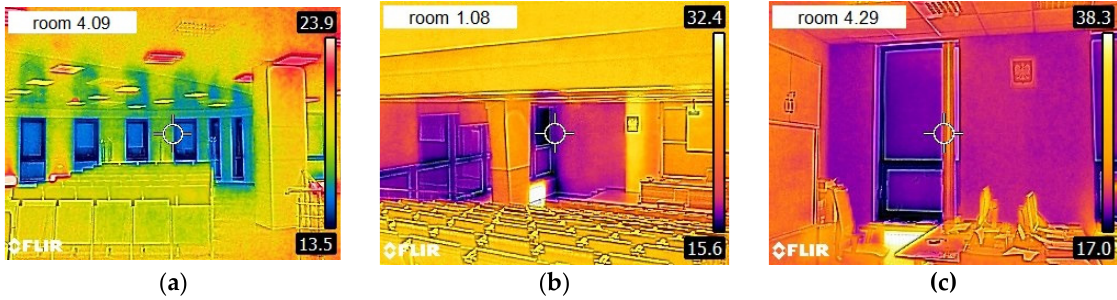
Figure 2. Thermal images from “Energies” ( a ), building “A” ( b ) and Courthouse ( c ). The ventilation ducts (both for air supply and removal) in the intelligent buildings are located in the suspended ceilings. Cooling is provided with the cassette indoor units (in “Energis”) and with fan coils (in the Courthouse) connected with the outdoor chillers (located on the rooftops). Heating in all the considered buildings has been achieved with hot water radiators (“A” building and Courthouse) as well as floor heating (only in the case of “Energis”). In “Energis” air heating with the cassette indoor units is also available. The temperature in intelligent buildings can be changed by room users with the control panels situated in each room. The range of allowable changes is fixed and determined in the BMS system. In both intelligent buildings the mechanical ventilation system is equipped with heat recovery units (rotary heat exchangers). Air treatment in central air handling units (lo- cated on the rooftops and in the basement) involves filtering, heating, and heat recovery. Partial air recirculation is also used to reduce operational costs (however a minimal fresh air flowrate must be maintained for breathing). In the two buildings steam vaporisers are installed on selected systems. The cooling system in both buildings consists of rooftop chillers, which operates at the parameters 7 °C (supply)/12 °C (return) at the Courthouse and 6 °C/12 °C for “Energis” circulating between the indoor units and the chillers (multi- split systems). Air from the toilets is removed outside using exhaust fans; however, in the case of “Energis” it undergoes a heat recovery process in air heat pumps. The Courthouse has 18 separate systems for air supply and removal with the designed air flowrate ranging